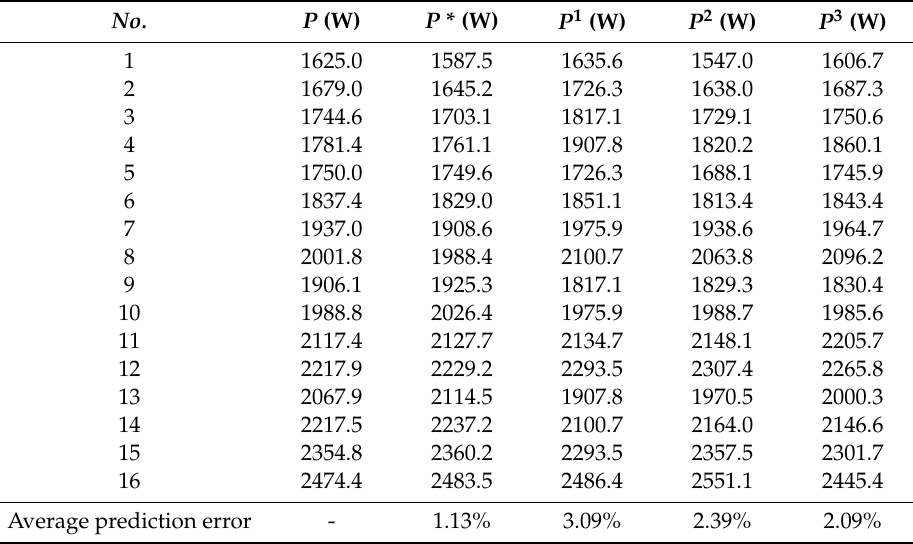
Table 5. Comparing di ff erent power models with the data from